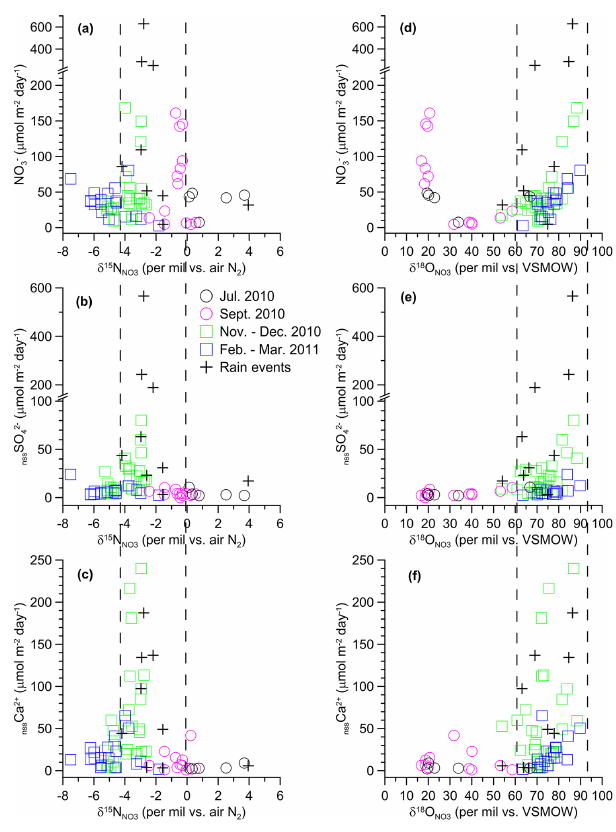
Fig. 5. Scatter plots of δ 15 N NO atmospheric deposition fluxes of NO − 2 + (c, f) . The dashed lines cover the δ 15 N nss Ca ranges corresponding to higher deposition fluxes of NO − and nss Ca 2 +